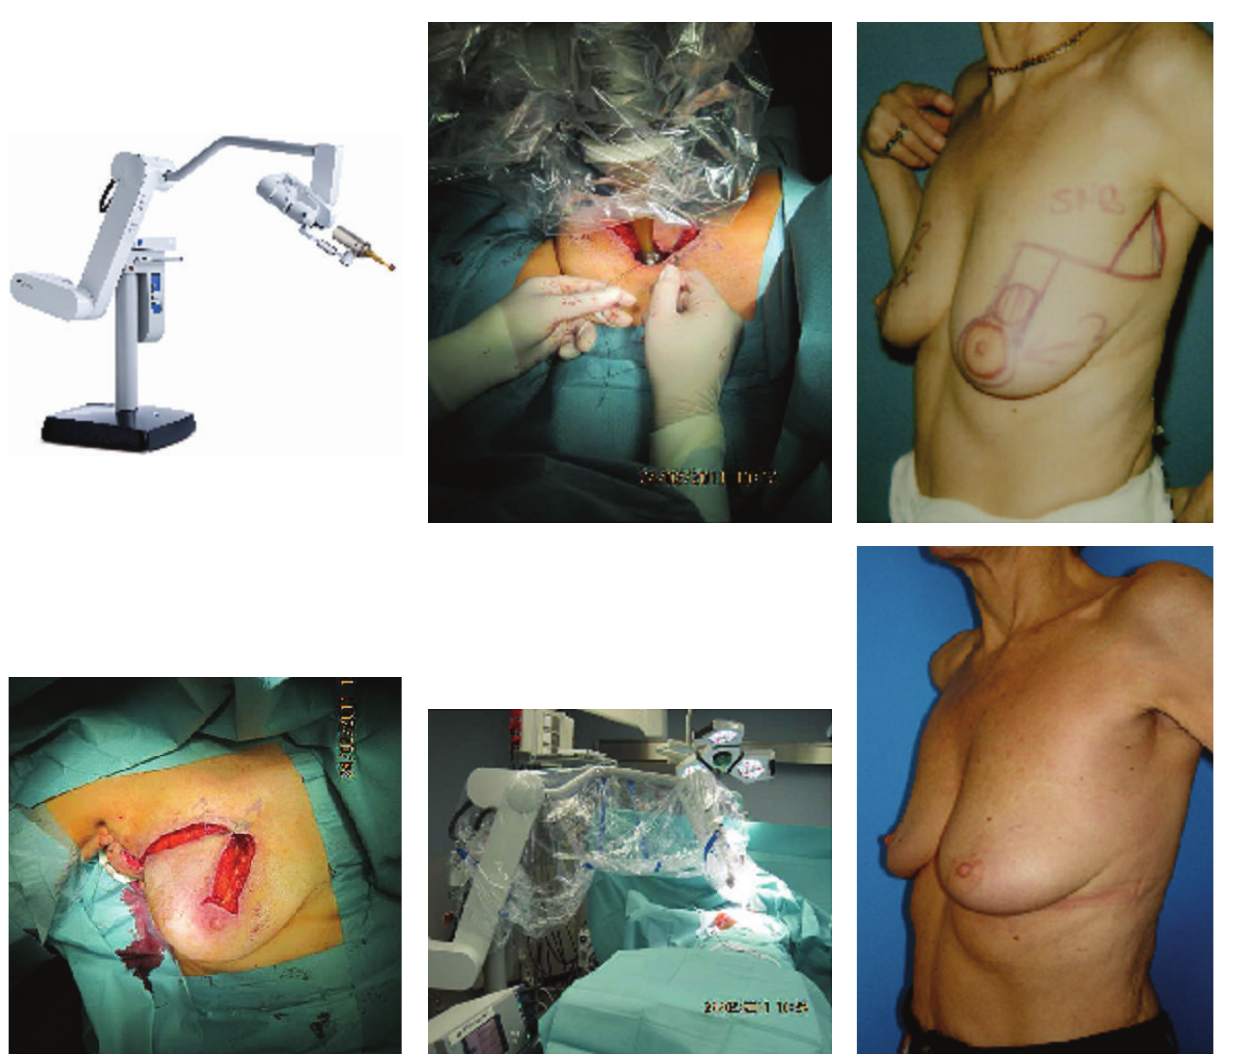
Figure 1: Combination of IORT boost irradiation with targeted oncoplastic breast-conserving surgery (dermoglandular rotation).